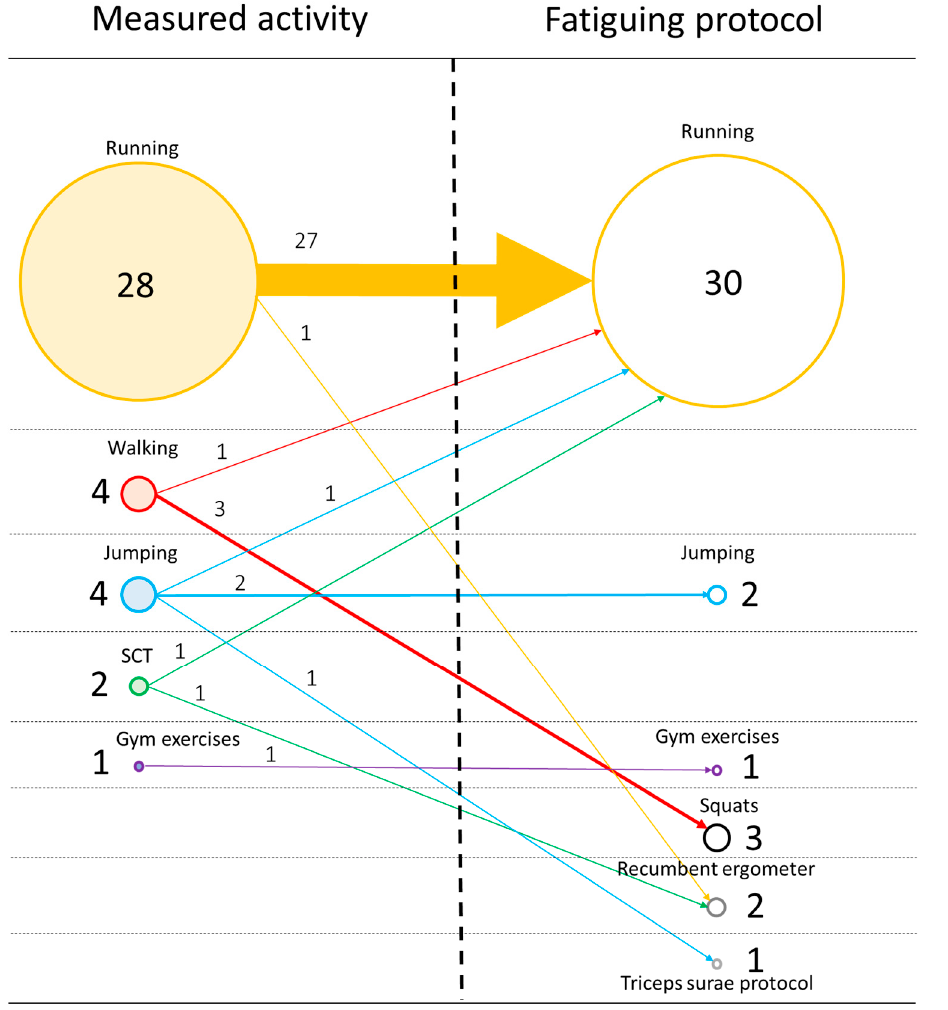
Figure 2. Summary of fatiguing protocols and measured activities. Circles on the left side represent the number of articles that measured each PE activity, while circles on the right side represent the number of articles for each PE activity chosen as a fatiguing protocol. Horizontal arrows represent the articles that used the same fatiguing protocol PE activity as the measured activity, while diagonal arrows represent the articles that chose a different PE activity.